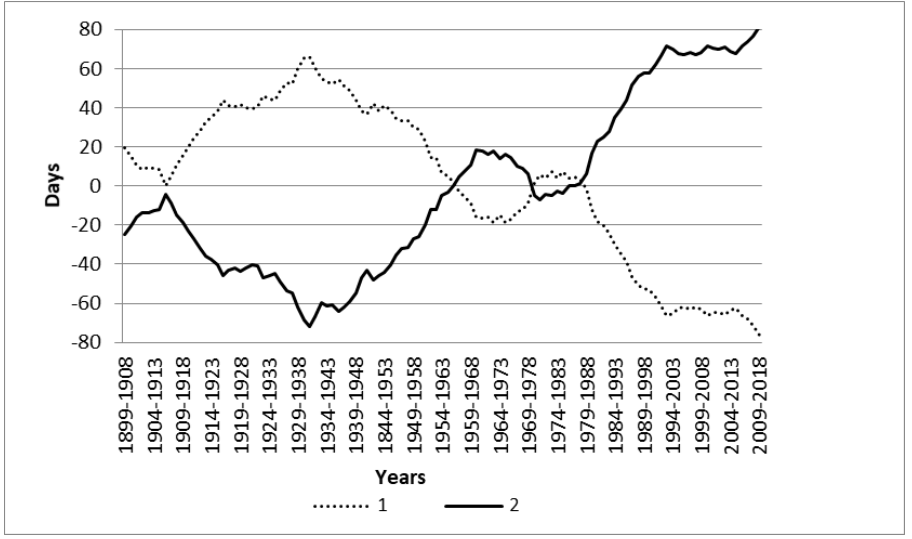
Figure 3. The anomalous occurrence (days) of (1) zonal flows (Type 1 and 2, dashed), and (2) meridional flows (Type 3 and Type 4, solid) from 1899 to 2018 means since the beginning of the 21st